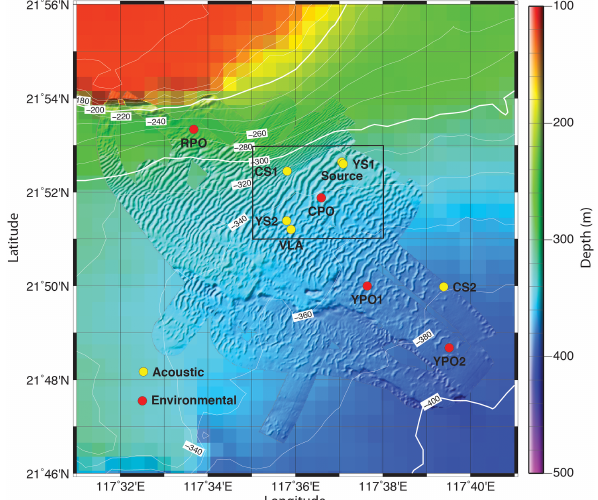
Figure 1. Locator map for the Sand Dunes 2014 field experiment. This paper primarily concerns the environmental moorings indi- cated by the red dots, although temperature from the “source” moor- ing is also used. The area within the black box is expanded in Fig. 2.